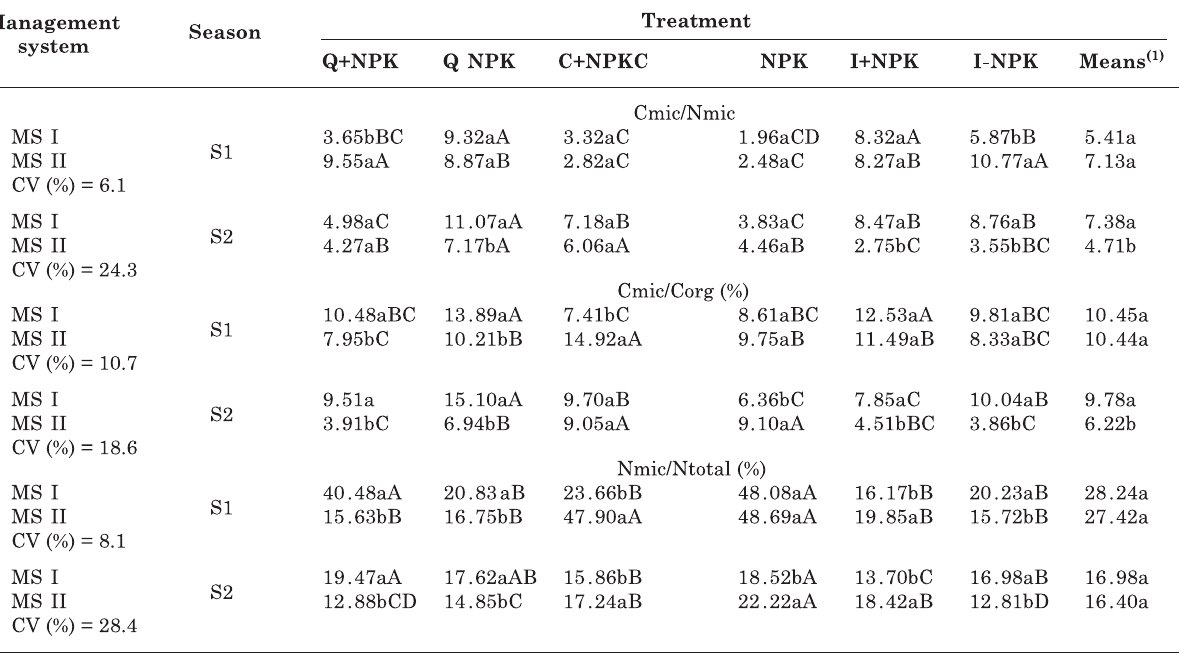
Table 1. Relations of microbial carbon and nitrogen (Cmic/Nmic) and of microbial and organic carbon (Cmic/ Corg), microbial and total nitrogen (Nmic/Ntotal), under two land use systems, under